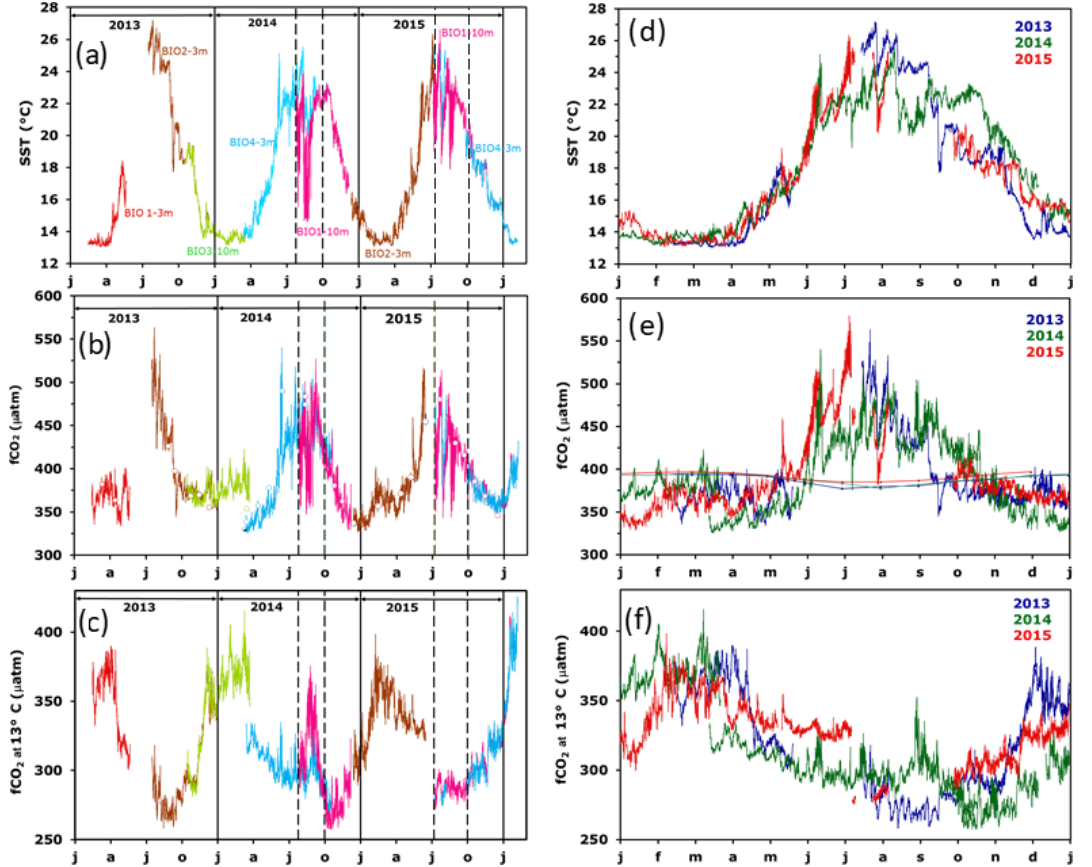
Figure 2. Inter-annual variability of CARIOCA data on the BOUSSOLE mooring; left column represents a function of time and right column a function of months for a given year (blue for 2013, green for 2014 and red for 2015). (a, d) T, (b, e) f CO 2 and (c, f) f CO 2 @13 ◦ C. In (a–c) , the dotted lines indicate the period affected by stratification and internal waves (26 July to 1 October 2014 and 8 July to 1 October 2015). In (b) , the open circles correspond to f CO 2 data derived from DIC and alkalinity measurements of samples taken at 5 and 10m. In (e) , the thin lines indicate f CO 2atm . Note that the colour code on (d–f) is different from (a–c)